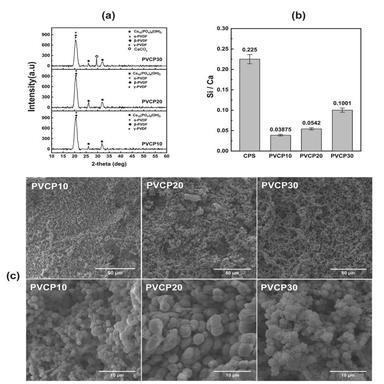
a) The XRD patterns of samples removed from the surface of CPS-PVDF scaffold after 28 d of mineralization study in SBF and (b) the Si/Ca ratios were derived from the EDS information accompanied with SEM analyses. (c) The scanning electron micrographs of the surface of the CPS-PVDF scaffold after 28 d of mineralization under two different magnifications (1000X and 5000X, respectively).